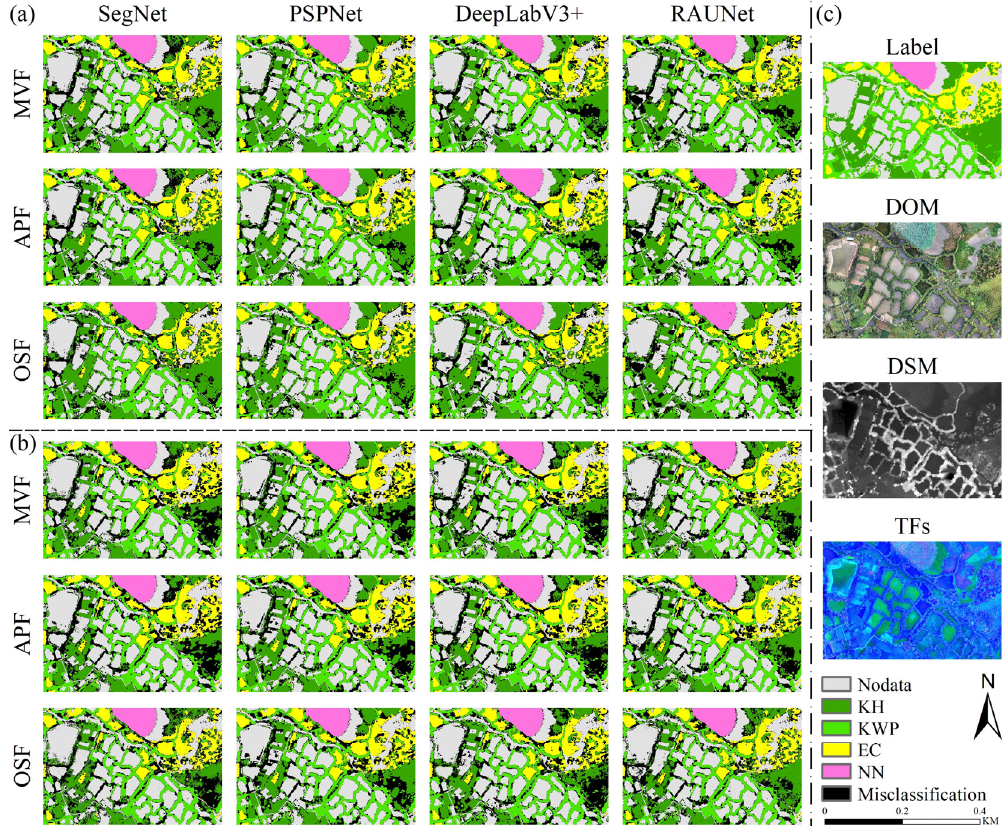
Figure 17. Results of OC-FCM and MC-FCM based on different algorithms for karst wetland vegetation. ( a ) OC-FCM, ( b ) MC-FCM, ( c ) semantic label and UAV data.